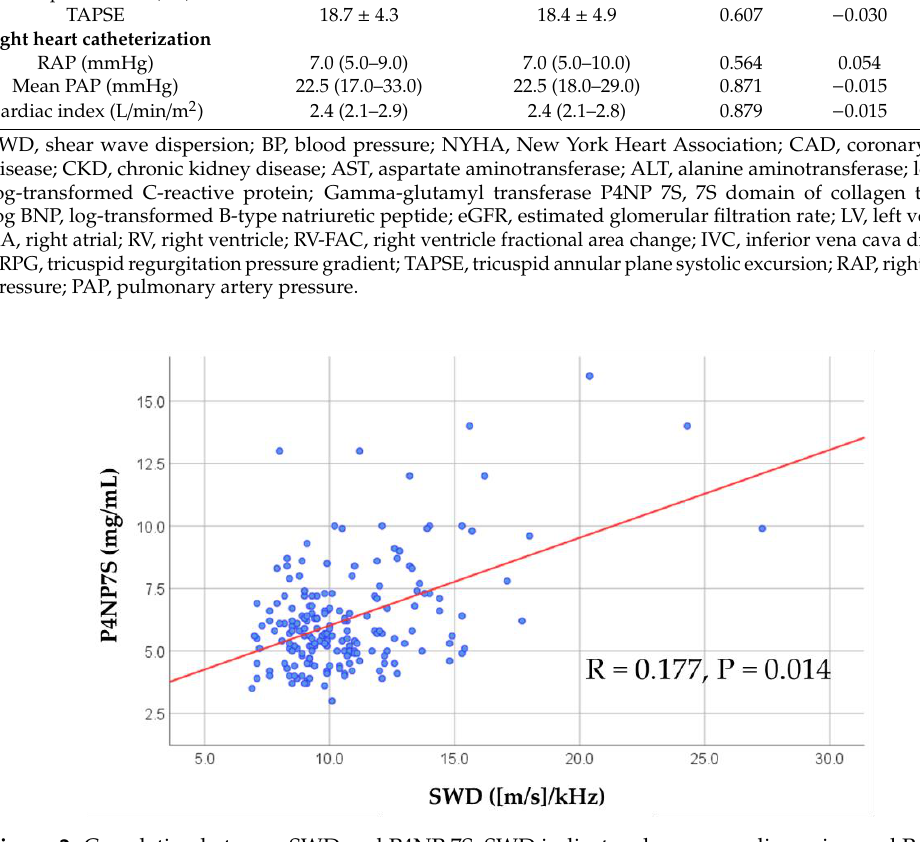
Figure 3. Kaplan–Meier analysis for cardiac event rates stratified by SWD levels. SWD indicates shear wave dispersion.